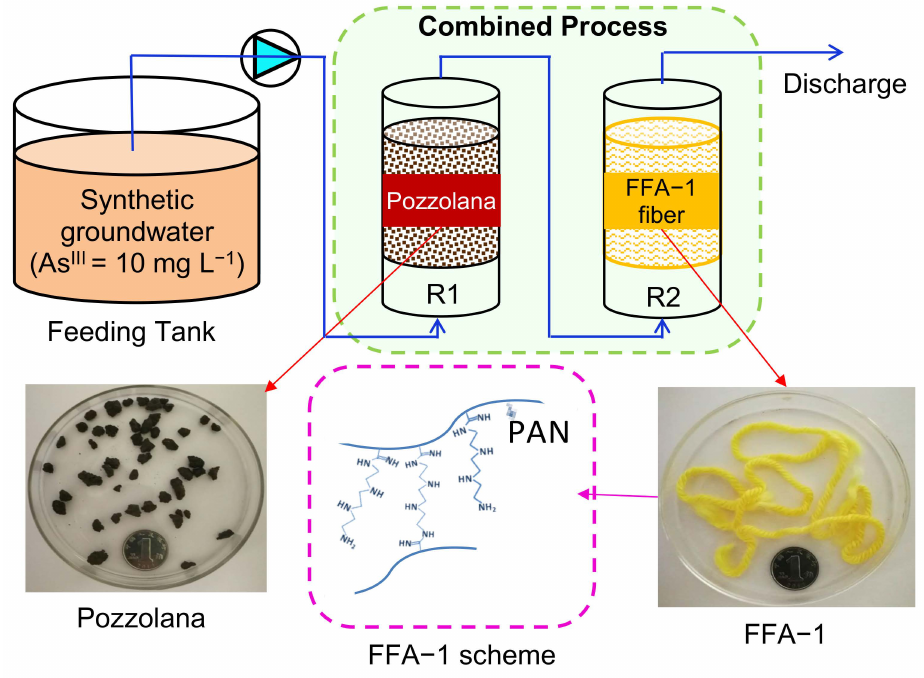
Figure 1. Schematic diagram of the combined system and filling